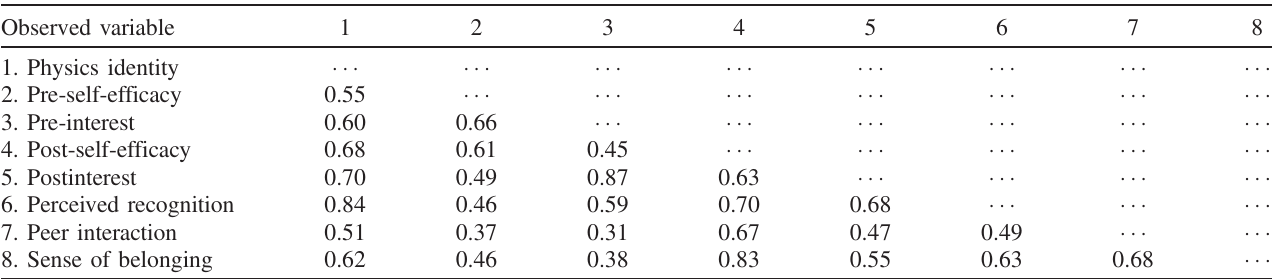
TABLE II. Zeroth order correlation coefficients of the constructs in the mediation model. Observed